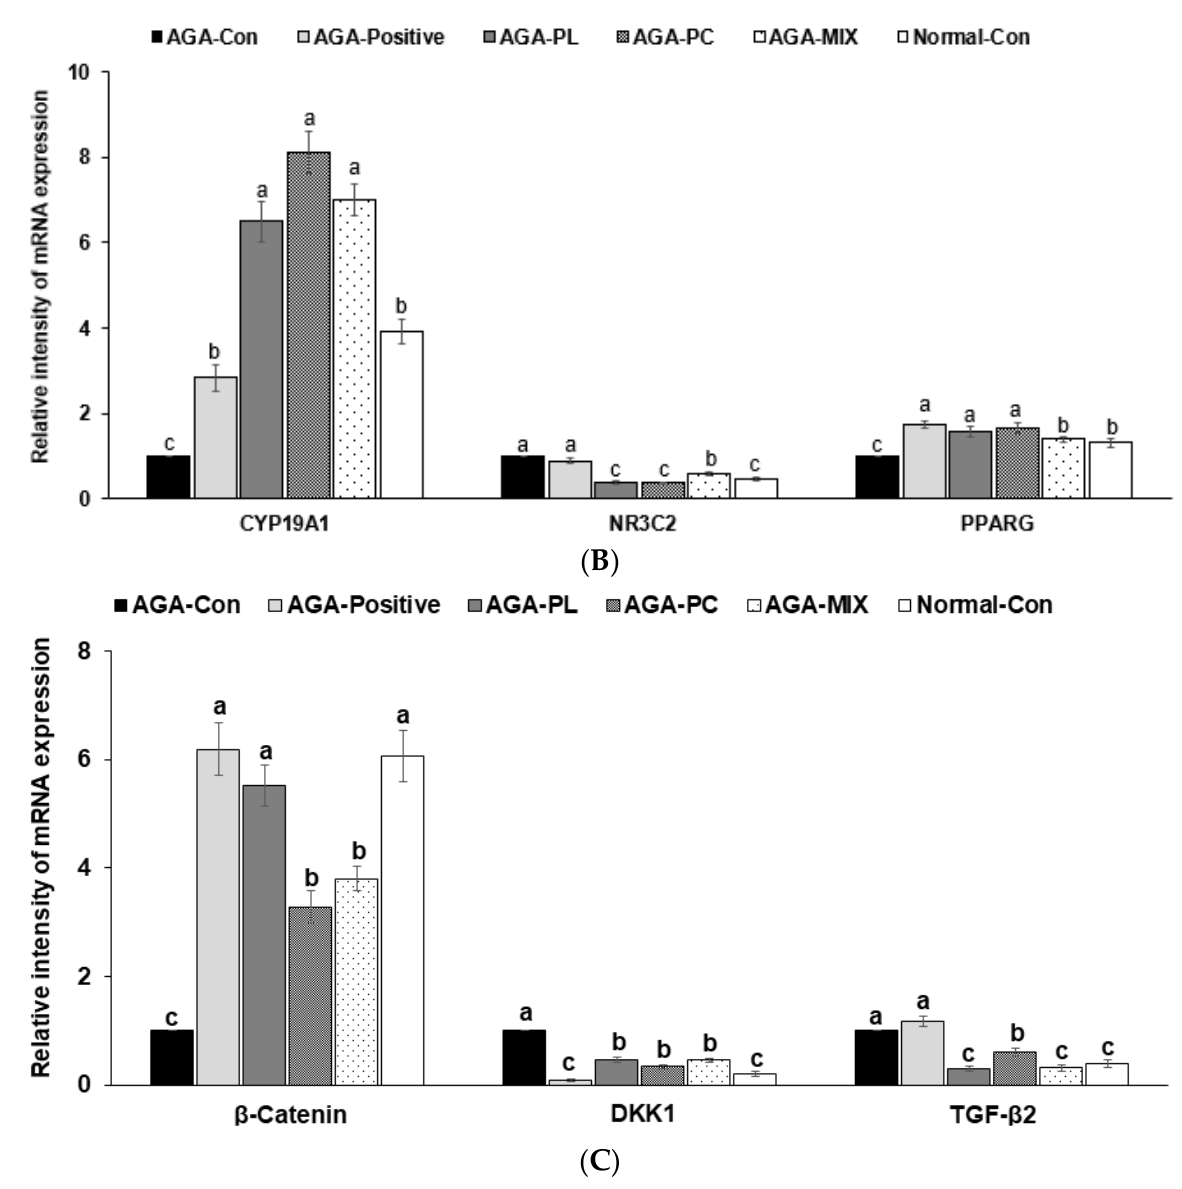
Figure 5. mRNA expression levels in the dorsal skin. ( A ) Tumor necrosis factor- α ( TNF- α ) and interleukin 6 ( IL-6 ). ( B ) Aromatase ( CYP19A1 ), nuclear receptor subfamily 3 group ( NR3C2 ), and peroxisome proliferator-activated receptor gamma ( PPARG ). ( C ) β -Catenin , Dickkopf-related protein 1 ( DKK1 ), and tumor growth factor- β 2 ( TGF- β 2 ). Bars and error bars are mean ± standard deviations (N = 4). a,b,c Different letters on the bars indicate a significant difference as per a Tukey test at p < 0.05, and no or the same letters indicate no significance between the groups. AGA was induced with the application of 0.5% testosterone propionate solution on the back of mice, and AGA-induced mice orally consumed 0.1% PL, 0.1% PC, or 0.1% mixture of PL and PC (1:1, w / w ) in a 43% fat diet (HFD), called AGA-PL, AGA-PC, or AGA-MIX groups, respectively. AGA-induced mice were daily applied with 2% finasteride on the back, as AGA-Positive (positive control). AGA-Positive and AGA-Con (control) mice had 0.1% cellulose (no effective activity in AGA treatment) in an HFD. Normal-Con did not induce AGA and consumed 0.1% cellulose in an HFD. All mice had an 8-week treatment.